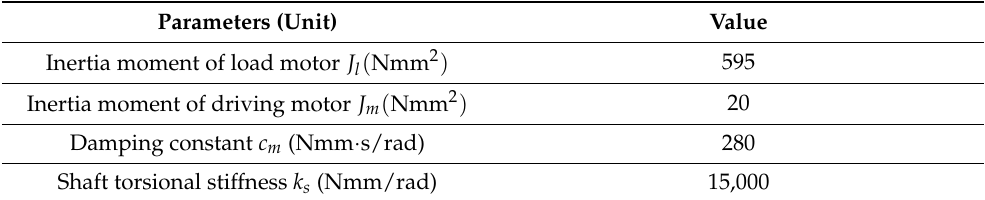
Figure 10. Convergence histories in system identification: ( a ) inertia moment of load motor, ( b ) inertia moment of driving motor, ( c ) damping constant, and ( d ) shaft torsional stiffness (inset: zoomed view of A). Table 3. Tuning parameters for the AEKF estimation model. Table 2. Identified system parameters of the rotating shaft